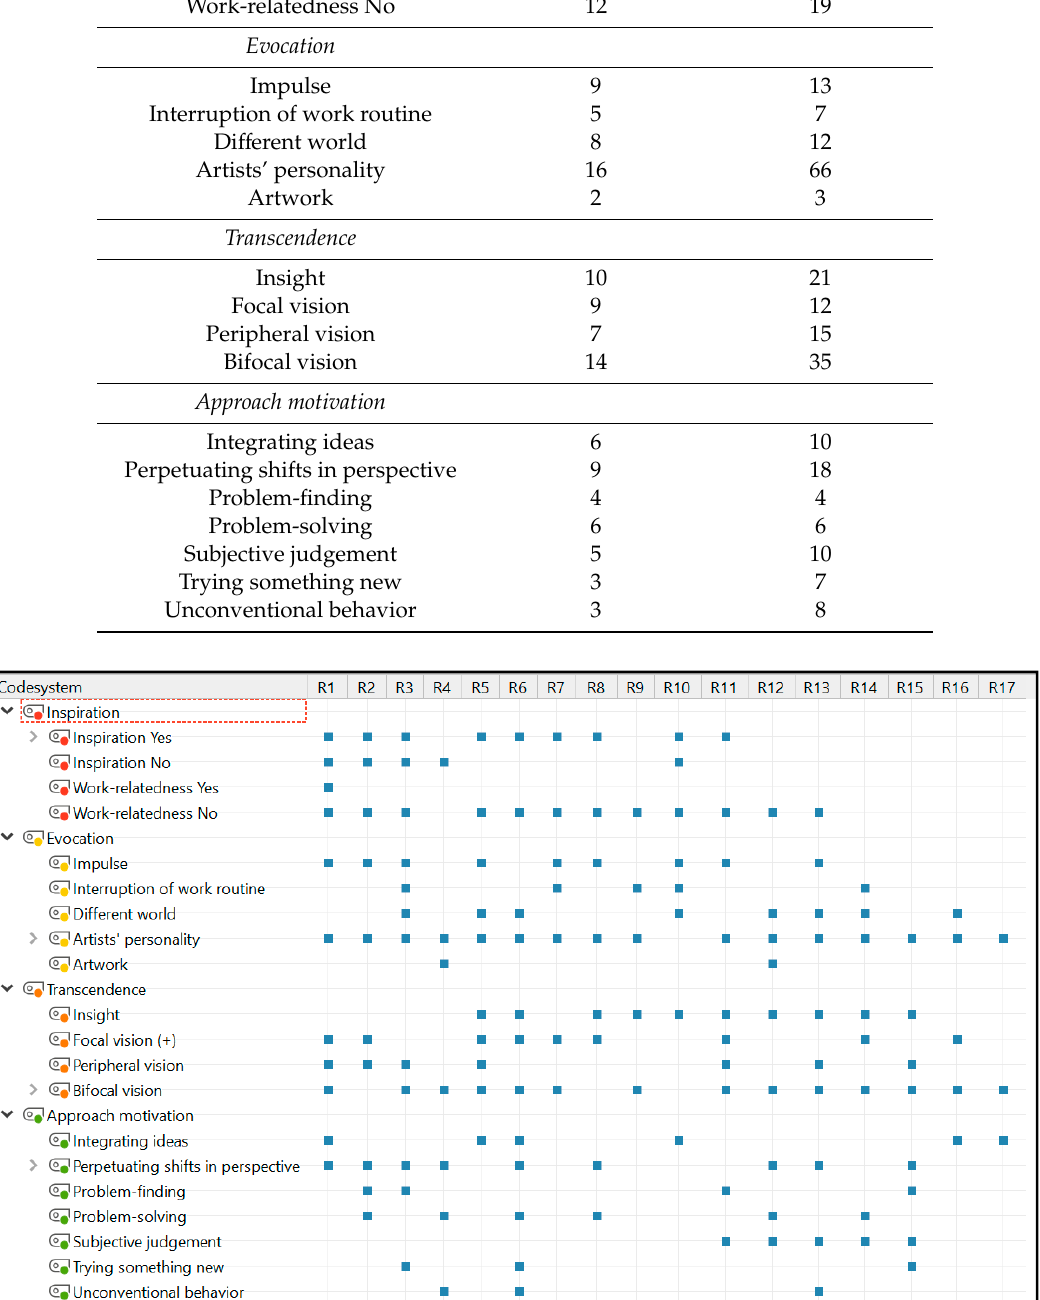
Figure 1. Summary grid.